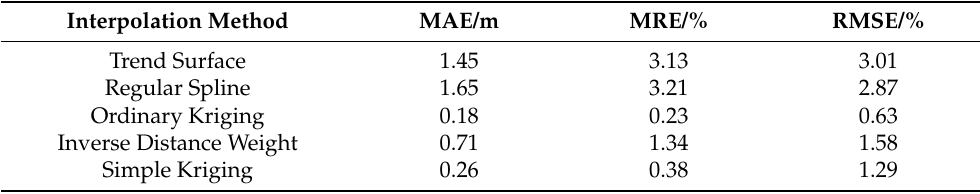
Table 3. Error statistics of the five methods for interpolating shallow groundwater depth in